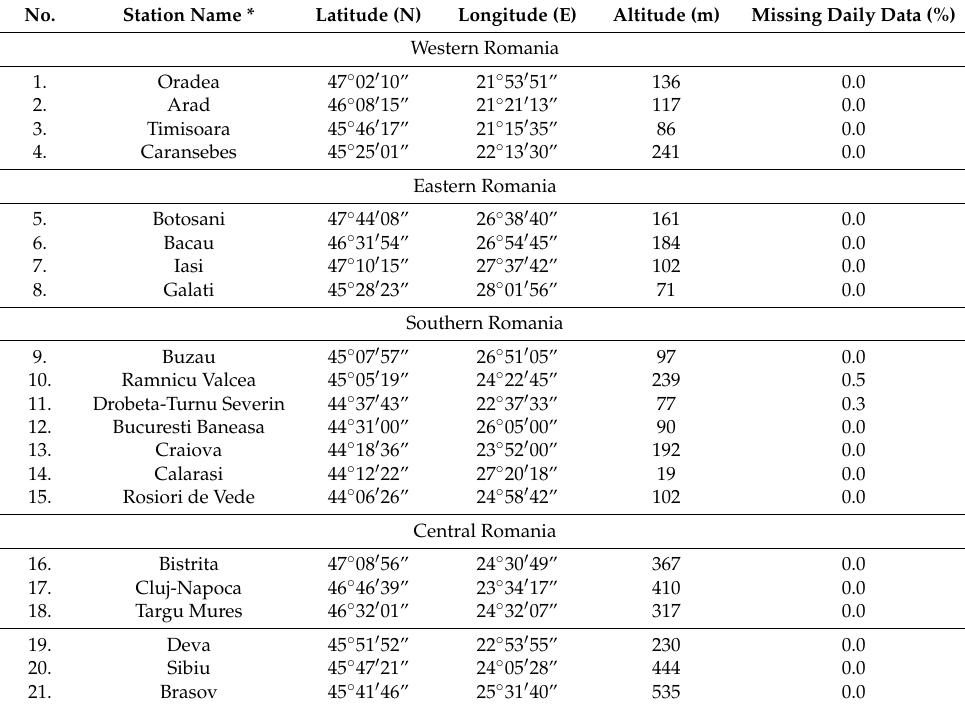
Table 1. Geographical coordinates of the weather stations considered.